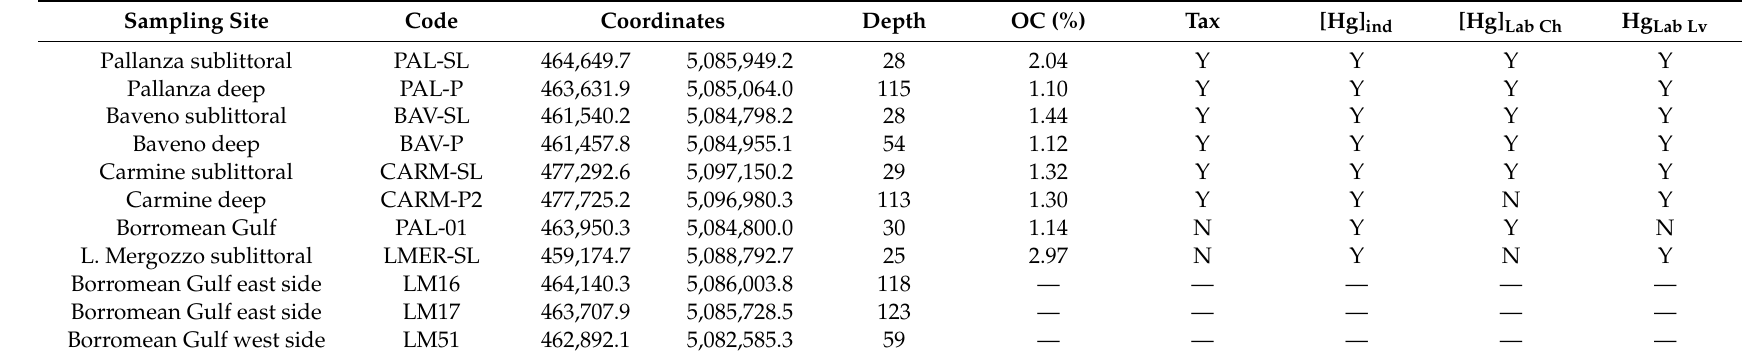
Table 1. Information on sampling sites and activities performed in lakes Maggiore and Mergozzo for the present study. Cores LM16, LM16 and LM51 were collected during previous studies [21,22] and used for data interpretation and comparison purposes. OC (%): organic carbon (in %); Tax: taxonomical identification (Yes / No); [Hg] ind : total Hg measurements in indigenous organisms (Y); [Hg] Lab : bioaccumulation tests with Ch ( Chironomus riparius ) and Lv ( Lumbriculus variegatus ) (Y / N); —: not analyzed or not performed.